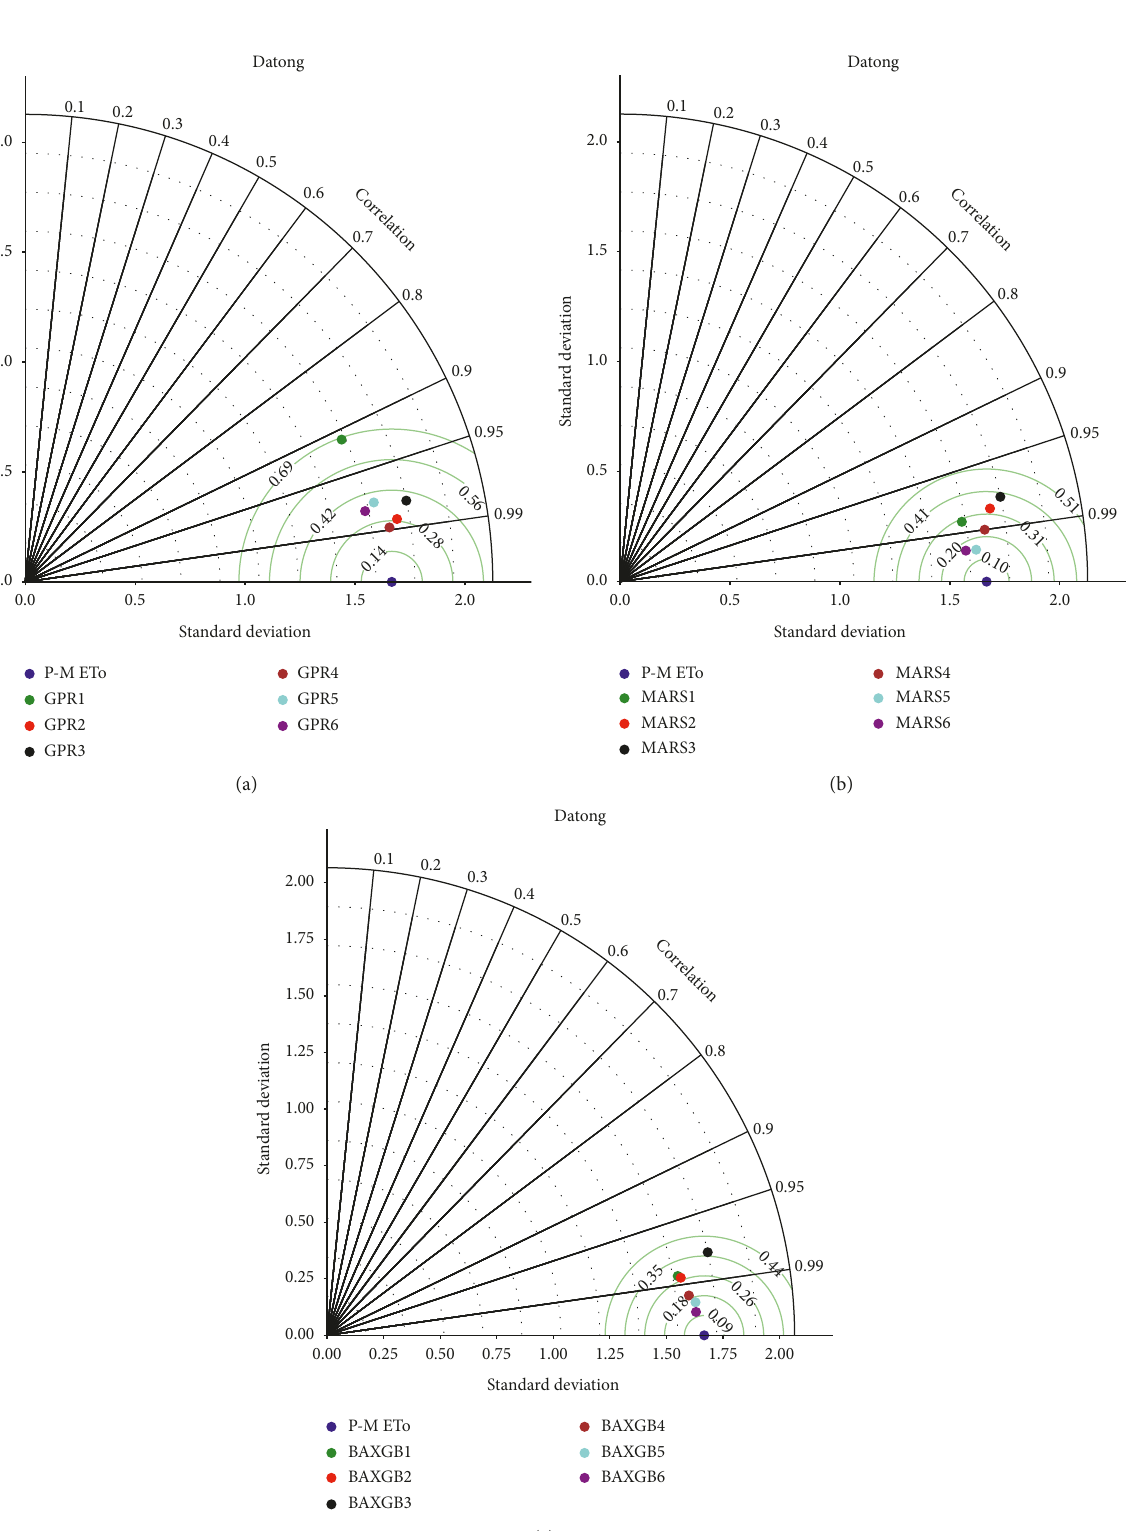
Figure 6: The Taylor diagram of (a) GPR, (b) MARS, and (c) BAXGB at the Datong